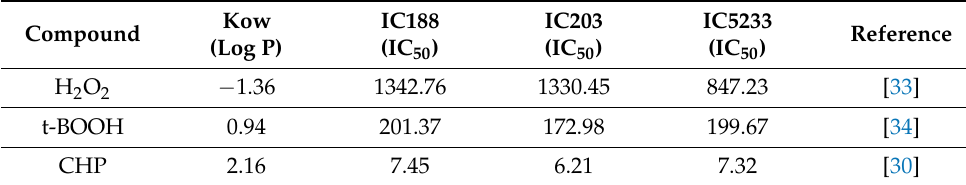
Table 2. Comparison between the lipophilicity (Kow) of the model compounds employed and their cytotoxicity in E.coli B